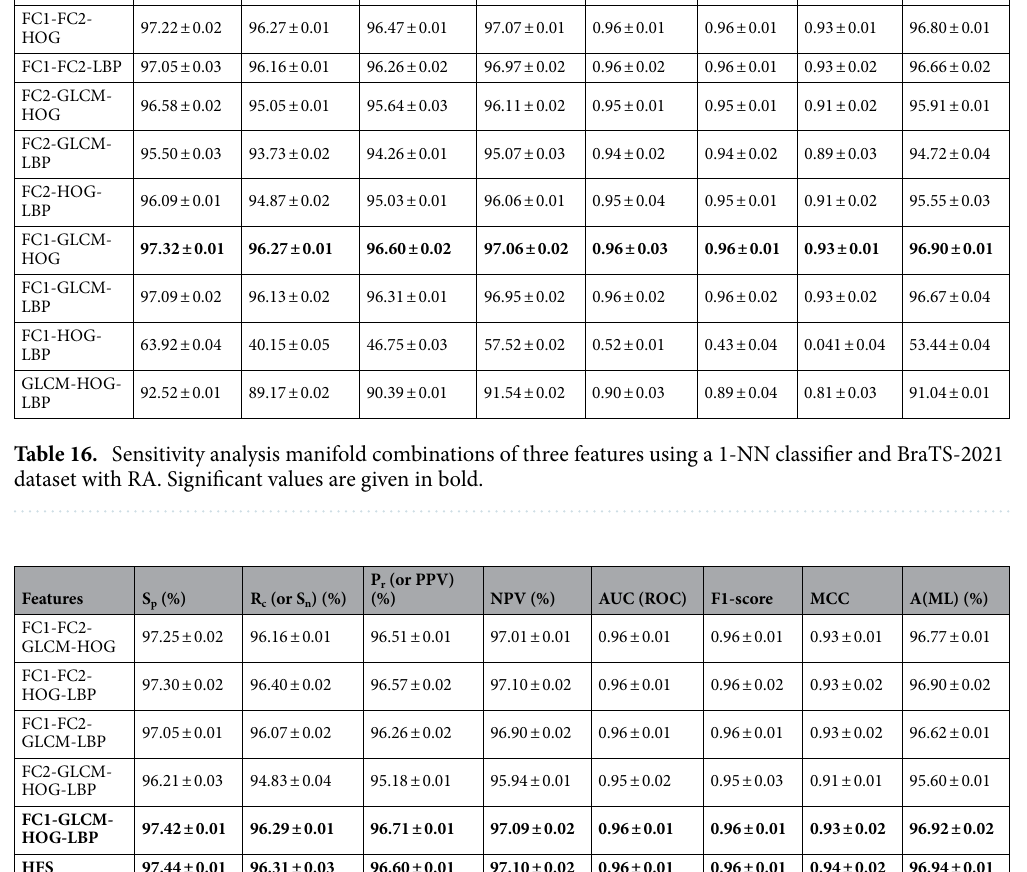
Table 17. Sensitivity analysis manifold combinations of four and five features using a 1-NN classifier and BraTS-2021 dataset with RA. Significant values are given in bold.